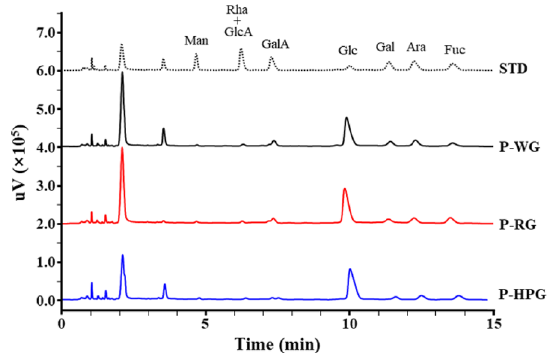
Fig. 4 Preparation and chemical properties of P‑WG, P‑RG, and P‑HPG. Overlaid chromatogram of monosaccharide composition analysis. The PMP‑labeled standards (0.1 μmol mix/tube) and each sample (200 μg/tube) were analyzed using ultra‑ performance